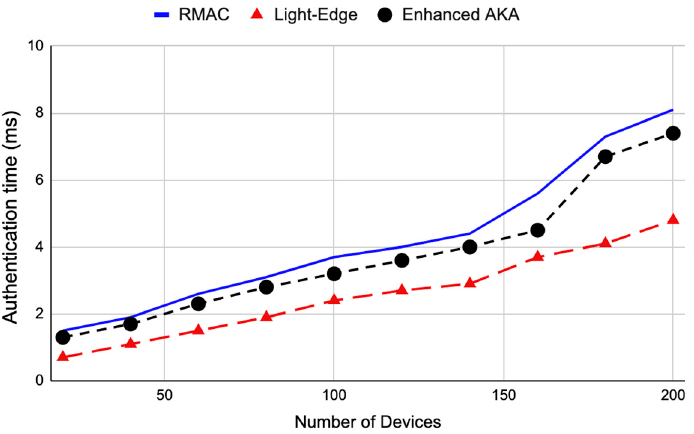
Figure 6. The authentication time of RMAC, Light-Edge, and enhanced AKA for different numbers of devices. Light-Edge outperforms the other protocols. of devices. Light-Edge outperforms the other